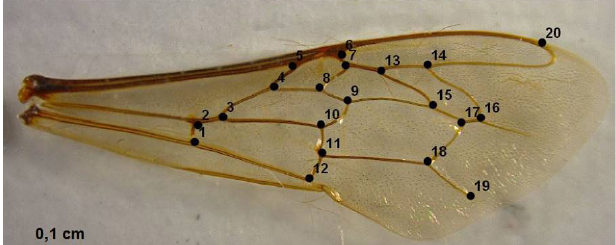
Fig 1 Right forewing of Melipona subnitida showing the 10 landmarks located at wing vein intersections, which were used in the morphometric analysis.